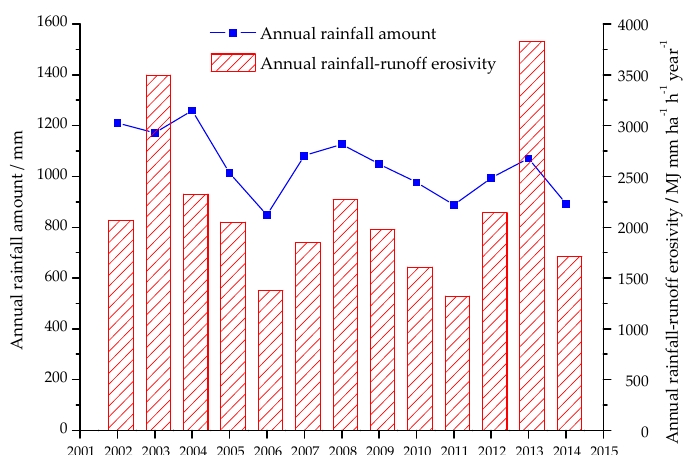
Figure 3. The relationship between annual rainfall amount and rainfall erosivity in the Wangjiagou agricultural watershed from 2002 to 2014.